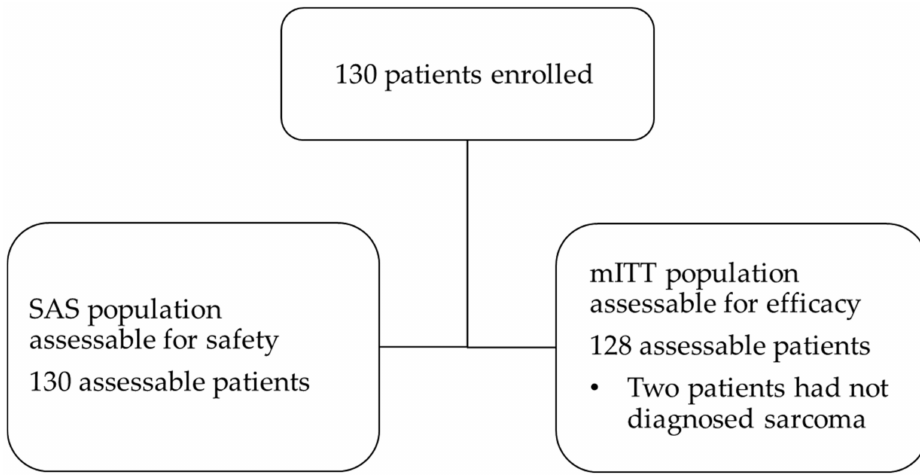
Figure 1. Description of included